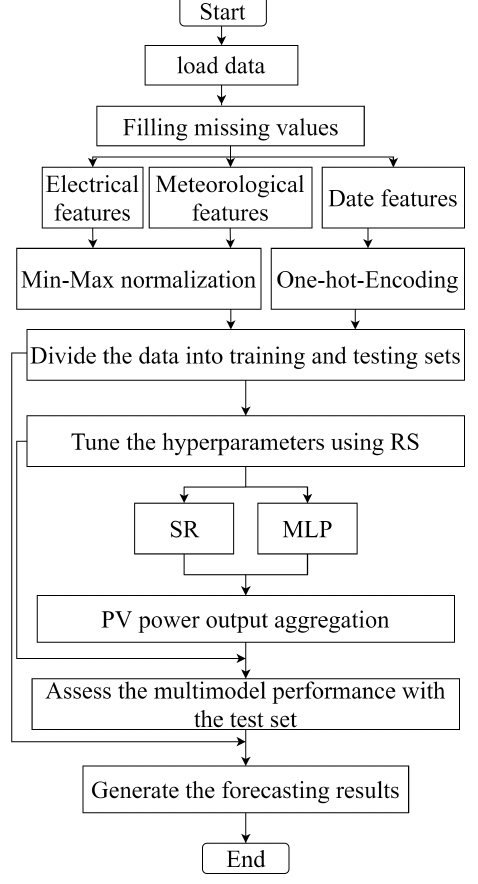
Figure 5. Flowchart of the proposed PV power forecasting